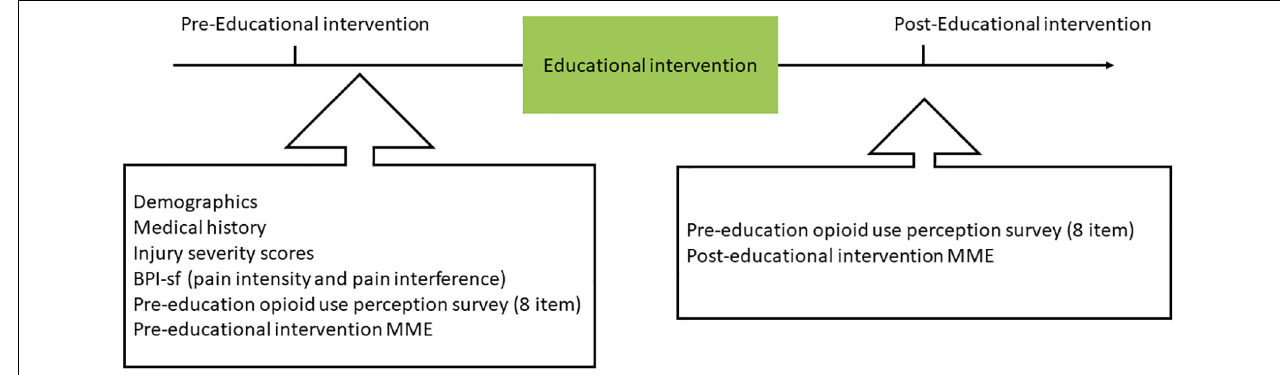
FIGURE 1 | Study procedure. Inpatients’ demographics, medical history, opioid intake, trauma injury severity, clinical pain intensity and interference, and opioid use perception were obtained before the educational intervention. After the educational intervention, the opioid use perception was re-assessed. Opioid prescription expressed in Morphine milligram equivalents (MME) were measured at discharge based on the medical records.